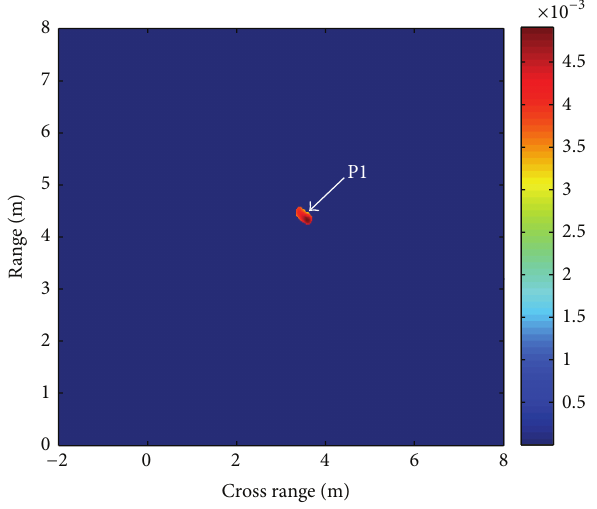
Figure 20: The ghost is mitigated by the proposed method in this